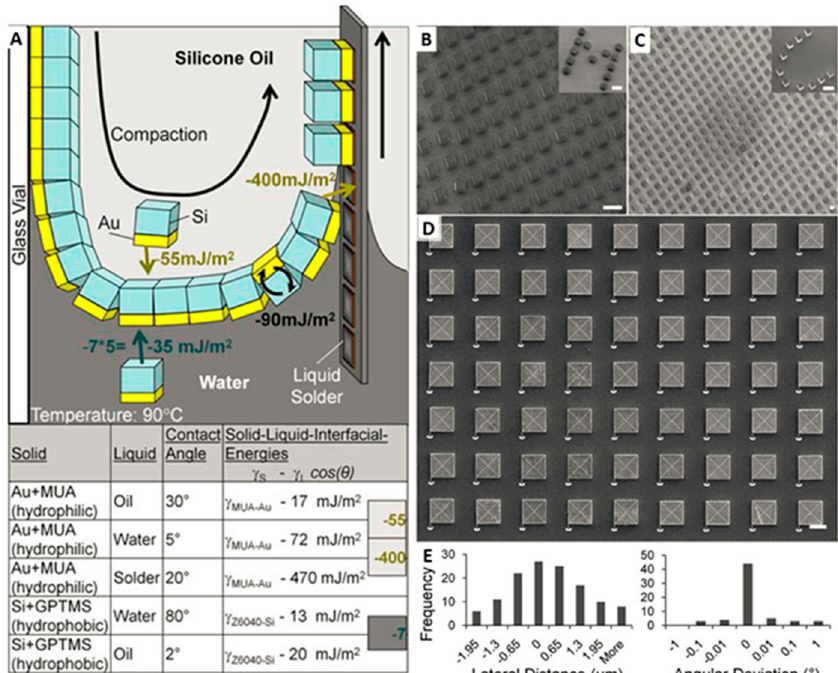
Figure 4. ( A ) Mechanism of surface tension directed self-assembly at a liquid–liquid–solid interface employing an energy cascade to (i) move components from a suspension to the interface, (ii) pre-orient the components within the interface to face in the right direction, and (iii) assemble the components on molten solder through dipping. The illustration depicts the situation for an oil–water interface and chiplets made out of Si (SU-8 is detailed in the main body), which carry an Au contact on one face. Depicted Au and Si surfaces are treated using hydrophilic mercaptoundecanoic acid (MUA) and hydrophobic 3-glycidoxypropyltrimethoxysilane (GPTMS) functional groups and yield the tabulated measured contact angles, calculated solid–liquid interfacial energies, and energy differences (gray boxes to the right) required to drive the assembly. The available area and curved shape of the interface cause the components to form a closely-packed 2D sheet. Upward motion of substrate yields a dynamic contact angle where the receding water layer becomes sufficiently thin for the gold to contact the solder. SEM images of SU-8 ( B ) and Si ( C , D ) chiplets assembling in regular arrays and arbitrary text patterns (insets). The overlaid CAD guides visible in (C, white lines) are used to measure variations in the center-to-center distance and angular orientation. ( E ) Histogram of measured variations. 40 µ m scale bars. From [40], copyright (2004) National Academy of Sciences, USA.